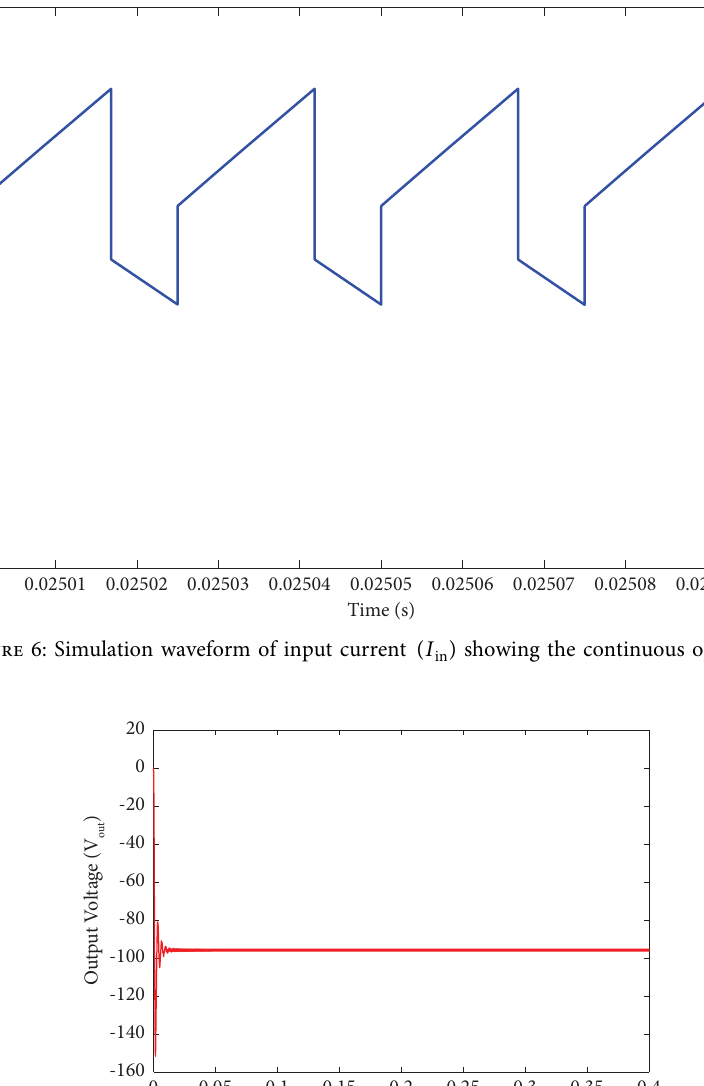
Figure 7: Te simulation result of output voltage with a ripple of